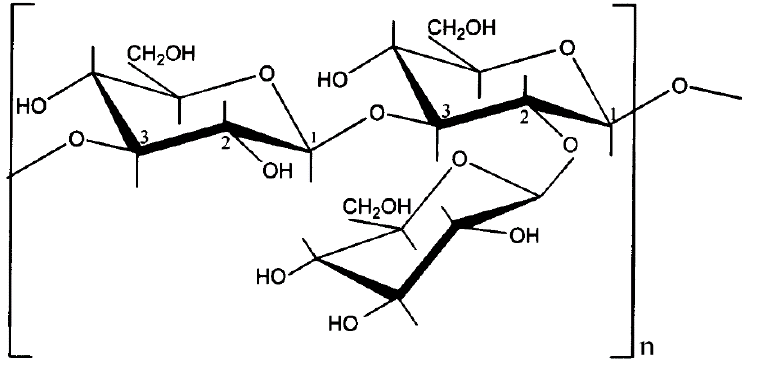
Figure 1. Repeat unit of the polysaccharide produced by Lactobacillus suebicus CUPV221.